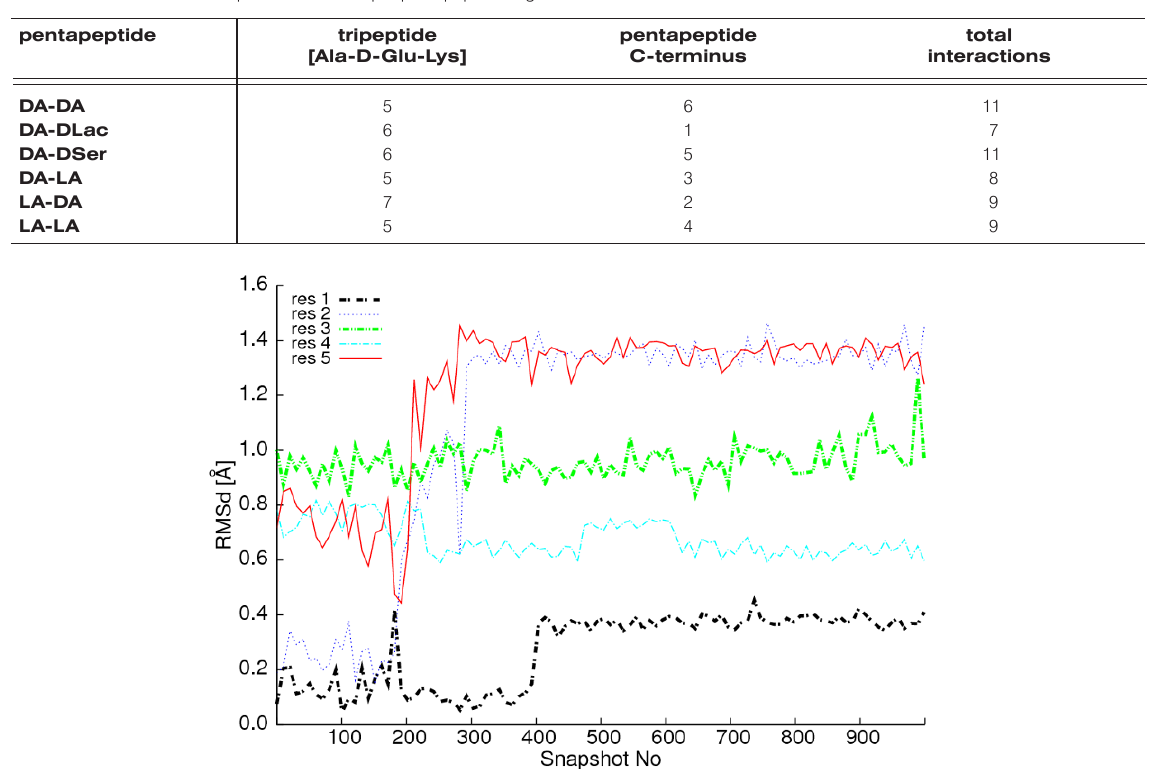
Figure 7. Plot of RMSd changes of LA-LA during unconstrained